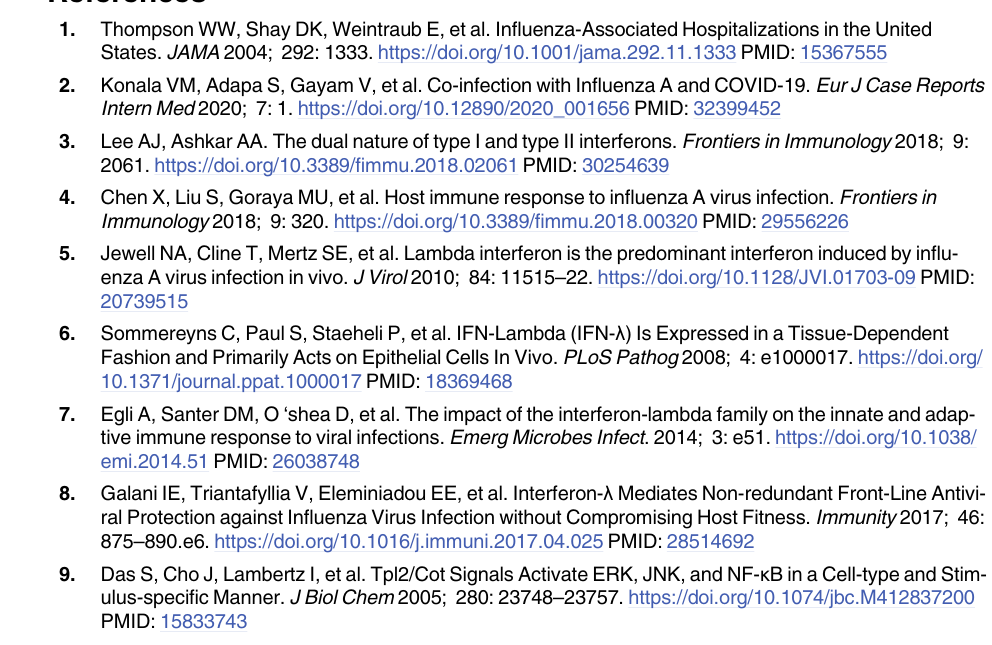
MPV- Mean platelet volume. N = 5 mice per